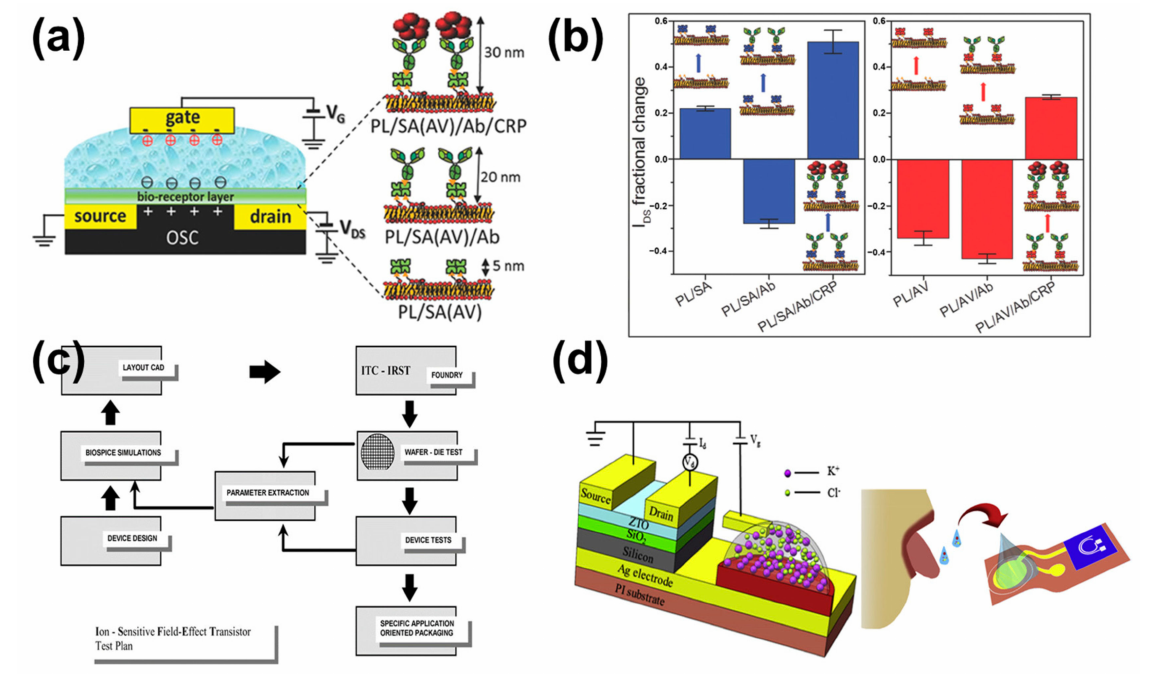
Figure 2. ( a ) The schematic representation of an EGOFET based on CRP detection and the reaction principle. ( b ) Transport properties of SiMoT after functionalization. ( c ) Test plan for ISFET-based microsystem design and fabrication. ( d ) The schematic representation of the construction of an ISFET for detecting ion concentrations in saliva. ( a ) Reproduced with permission [22]. Copyright 2015, John Wiley and Sons. ( b ) Reproduced with permission [22]. Copyright 2015, John Wiley and Sons. ( c ) Reproduced with permission [23]. Copyright 2005, Elsevier ( d ) Reproduced with permission [24]. Copyright 2019,